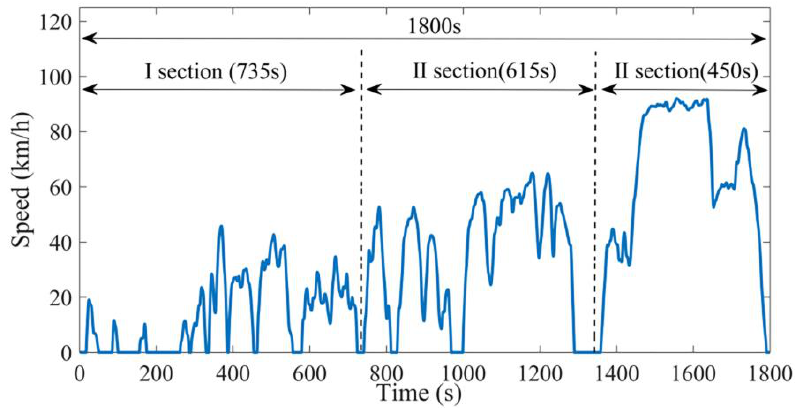
Figure 12. CLTC condition.